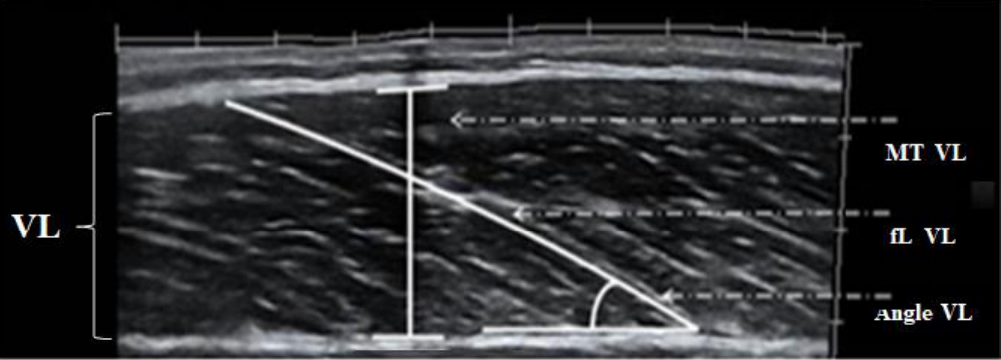
Figure 3. A comprehensive image of vastus lateralis (VL) muscle architecture including muscle thickness (MT), fascicle angle (Angle) and fascicle length (fL).